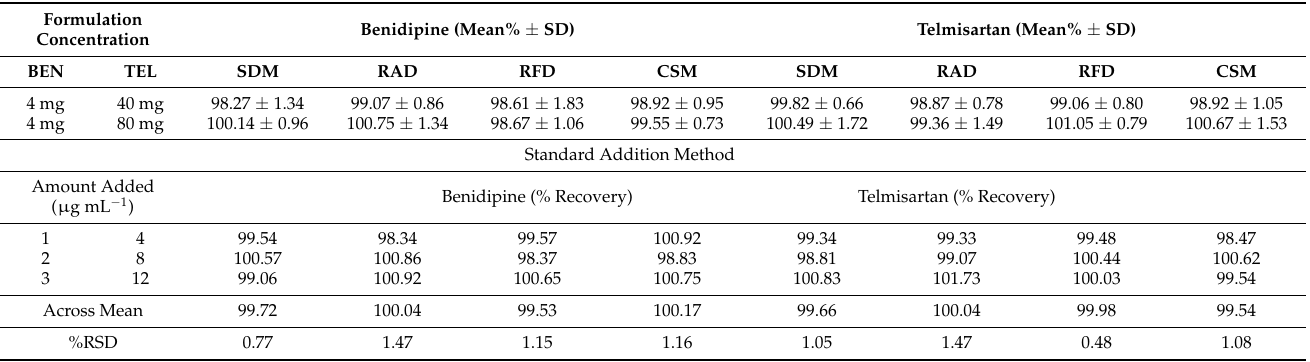
Table 4. Assay results of the formulation and the standard addition method